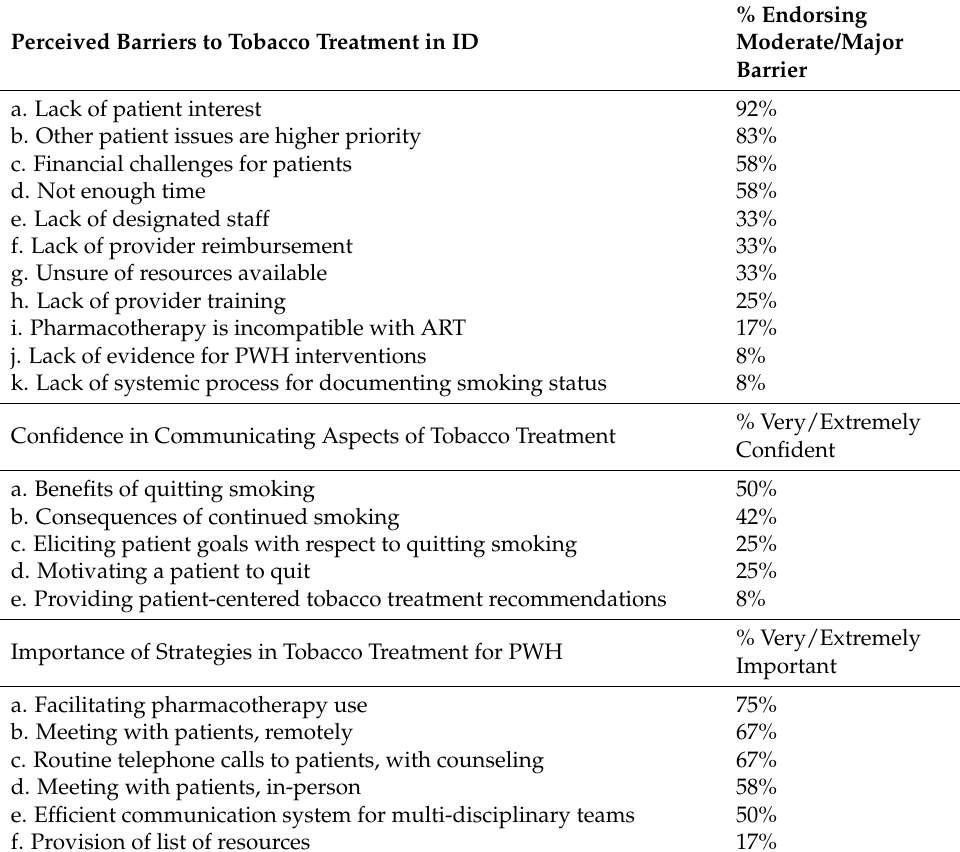
Table 1. Needs assessment